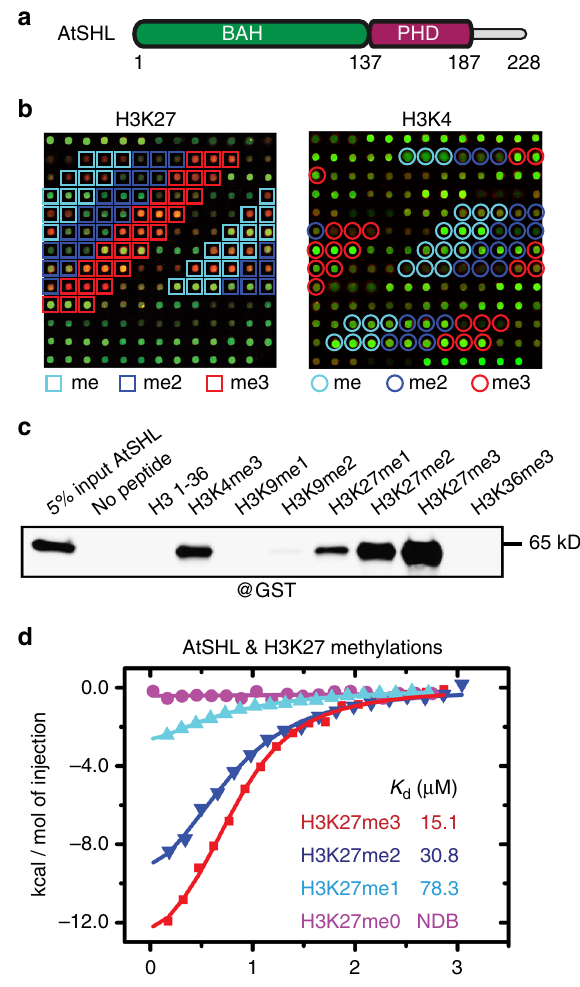
Fig. 1 SHL binds H3K27me3 and H3K4me3. a The domain architecture of Arabidopsis SHL (AtSHL). BAH, bromo-adjacent homology; PHD, plant homeodomain. b Systematic pro fi ling of histone binding preferences of full- length AtSHL on a histone peptide microarray. Representative array images showing that SHL preferentially binds to H3K27me3 and H3K4me3. Light blue, dark blue, and red squares represent the locations of mono, di, and trimethylated H3K27-containing peptides on the array, respectively. Light blue, dark blue, and red circles represent the locations of mono, di, and trimethylated H3K4-containing peptides on the array, respectively. c Immunoblotting analysis of histone peptide pulldown with full-length AtSHL. d ITC binding curves for complex formation between AtSHL and different H3K27 methylated peptides. NDB, no detectable